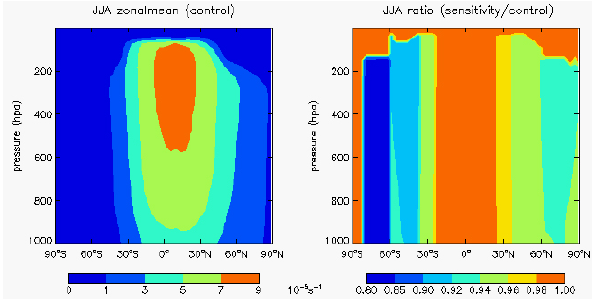
Fig. 1a. Changes in zonal mean photolysis rates of ozone J (O 3 ) due to stratospheric ozone recovery in December–February.